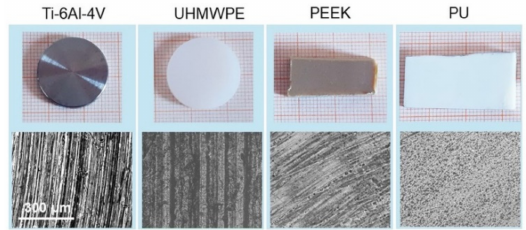
Figure 1. The four materials used in this work ( top ) and ( bottom ) corresponding 20 × optical images of their surfaces. The scale bar on the left is the same for all the